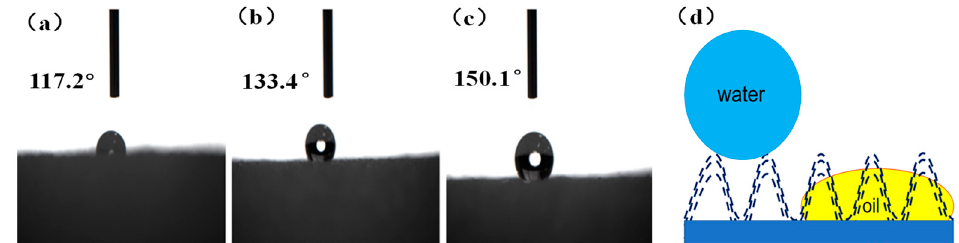
Figure 6. The water contact angle of ( a ) pristine PU sponge, ( b ) PU sponge with PDMS and without nano-Hap, ( c ) nano- HAp/PU sponge, and ( d ) superhydrophobic and superhydrophilic model.